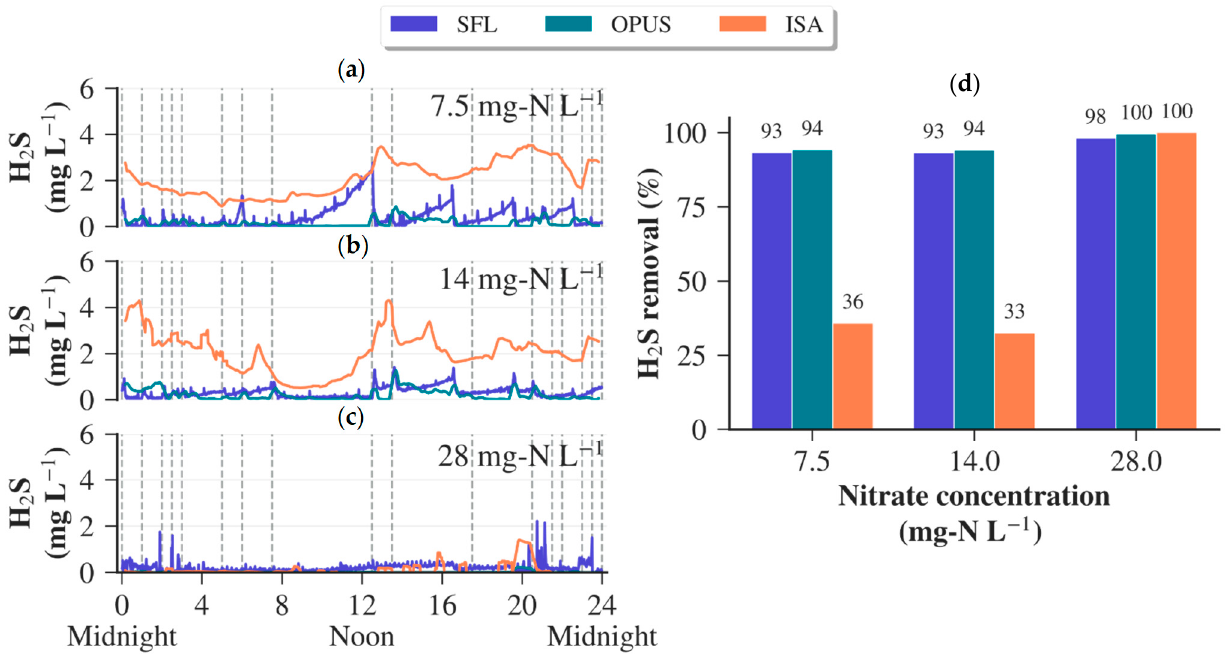
Figure 5. Response of the sensors during calcium nitrate dosing application. H 2 S profiles measured by the online sensors during limited (7.5 mg-N L − 1 ), optimal (14 mg-N L − 1 ), and overdosing scenarios (28 mg-N L − 1 ) ( a–c ). H 2 S removal percentages for the dosing scenarios ( d ). Removal percentages calculated using the median H 2 S concentration obtained during baseline and dosing trials. The vertical dash lines ( --- ) indicate the wastewater pumping periods.